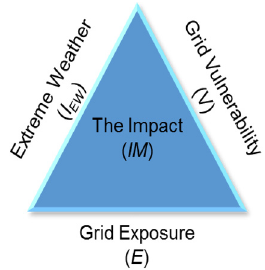
Figure 1. Illustration of the relationship between determinants of the impact. The size of the impact ( IM ) is determined by the intensity of the extreme weather event ( I EW ), the grid exposure ( E ), and the grid vulnerability ( V ).